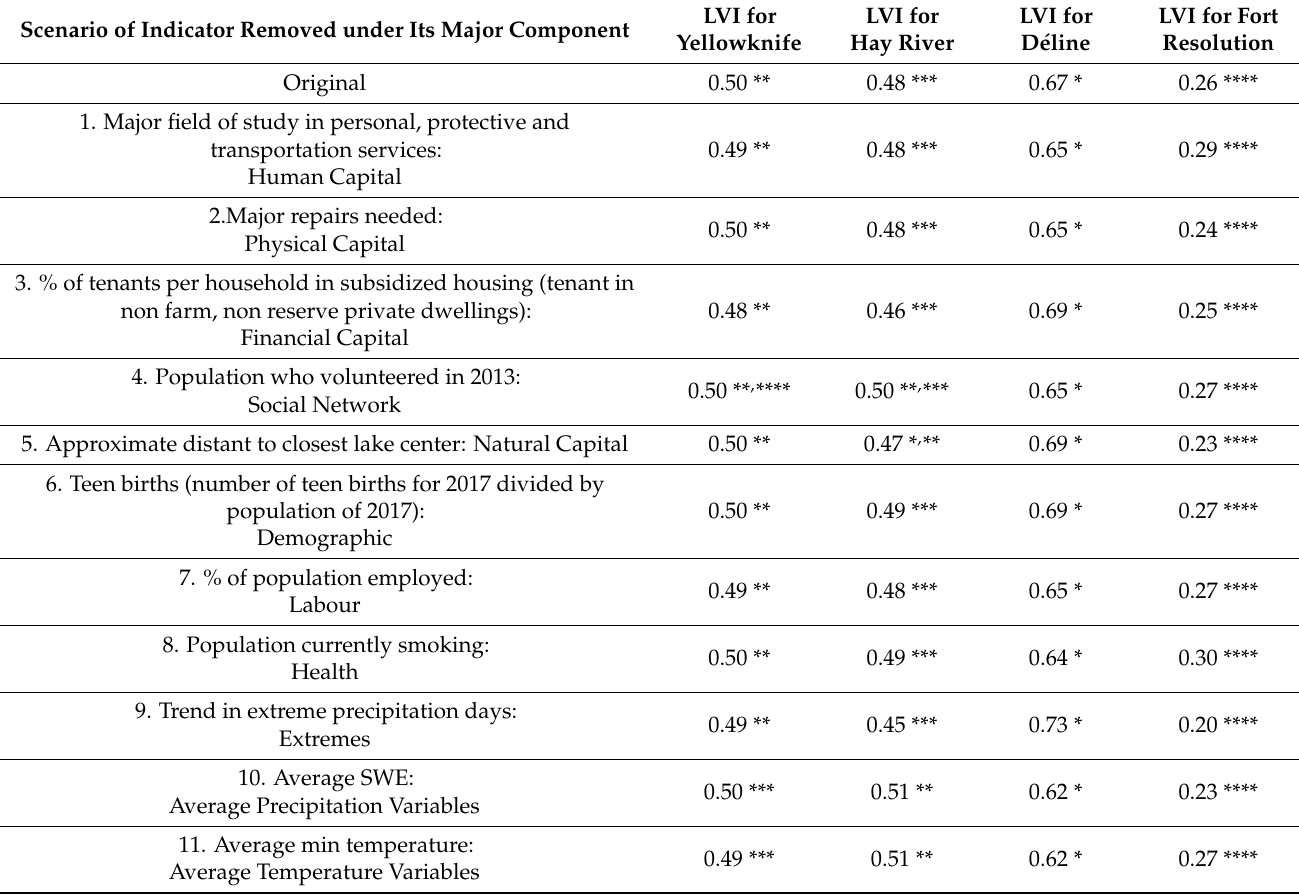
Table A3. This table shows the original LVI values for each community, compared to the LVI scenarios calculated when one indicator variable is omitted from the calculation under a specific major component. The symbols beside each LVI represent whether that community exhibits the highest, second highest, third highest, or fourth highest LVI in comparison to the other